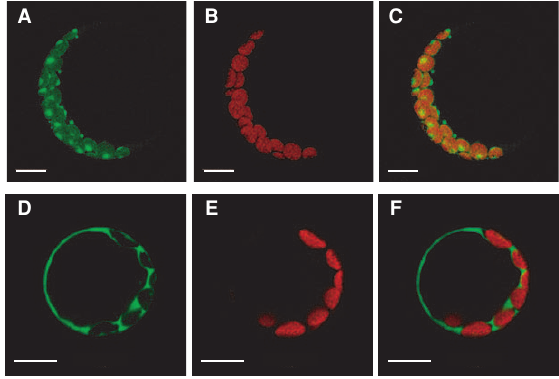
Figure 7. Chloroplast localization of a PGR7 N-terminus-GFP fusion protein in Arabidopsis leaf protoplasts. The protoplasts were transformed with either p21TPG3 encoding the PGR7 N-terminus- GFP fusion protein (A, B and C) or, as a control, p35 V -SGFP(S65T) encoding GFP itself (D, E and F). The green fluorescence images (A and D) were overlaid with chlorophyll autofluorescence images (B and E) to generate merged ones (C and F). The bar represents 10 m m.